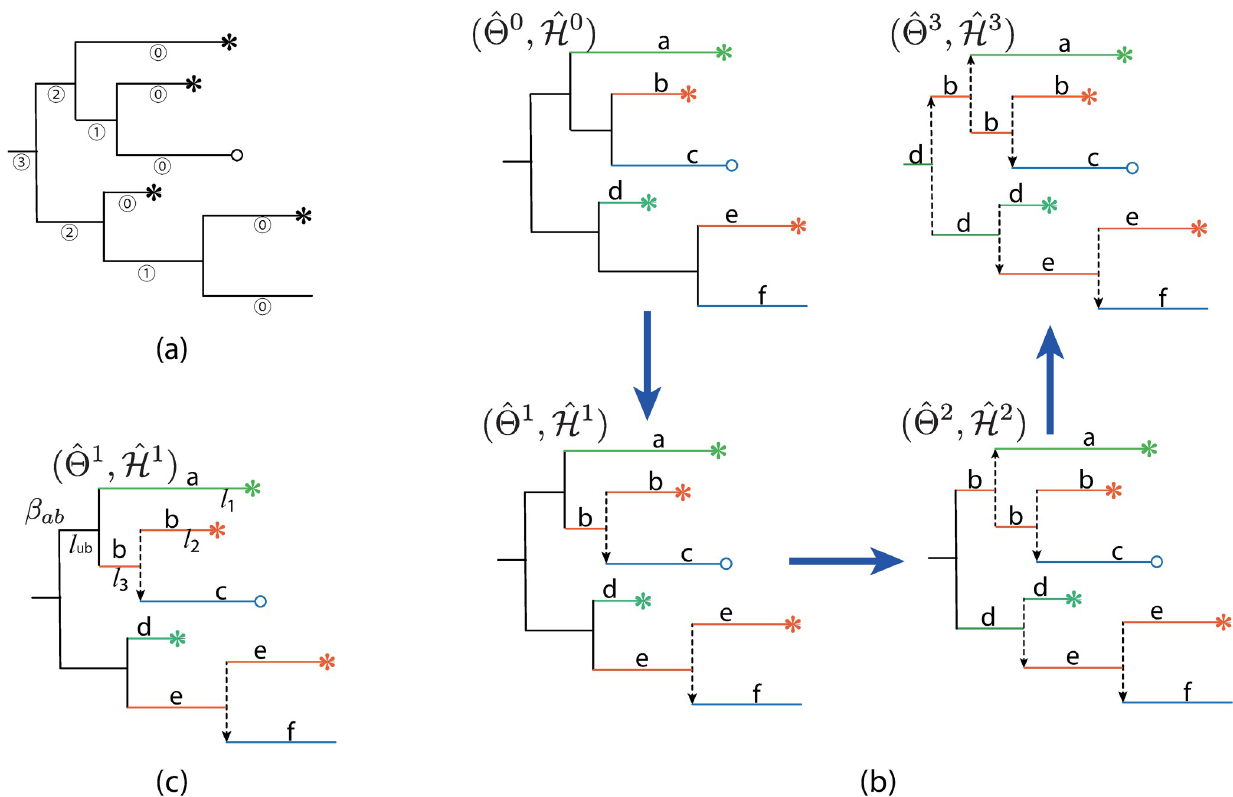
Fig 2. Schematic representation of the coordinate-ascent algorithm. (a) The branches in the genealogy G have been divided into 4 slices (labeled as ⓪ to ③ ). (b) The algorithm performs estimation of model parameters (denoted as Θ ) and reconstructing the transmission history H (or labeling the branches (with different letters) of a genealogy) simultaneously under the likelihood framework. The algorithm starts from the external branches (labeled as ⓪ ) which come from different individuals, and proceeds backwards slice by slice. The internal branches with the same label represent the infectious period of a particular individual, who is the infector of the transmission events during that period. (c) Given the present estimate of model parameters and transmission history ( ^ Y 1 , ^ H 1 ), the transmission histories of individual a and b are ( d